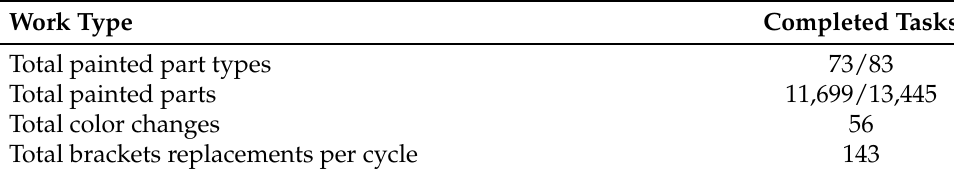
Table 4. The results of Rule-Based Scheduling